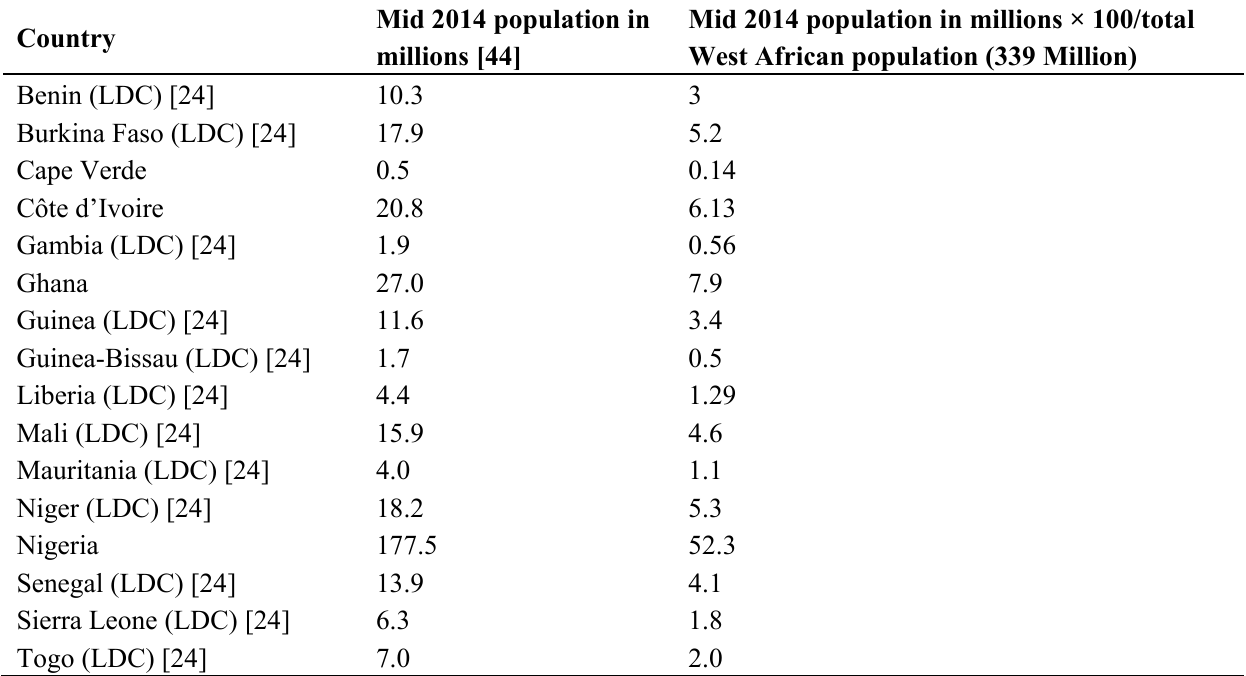
Table 1. Mid-2014 populations (in millions) in West Africa by country.